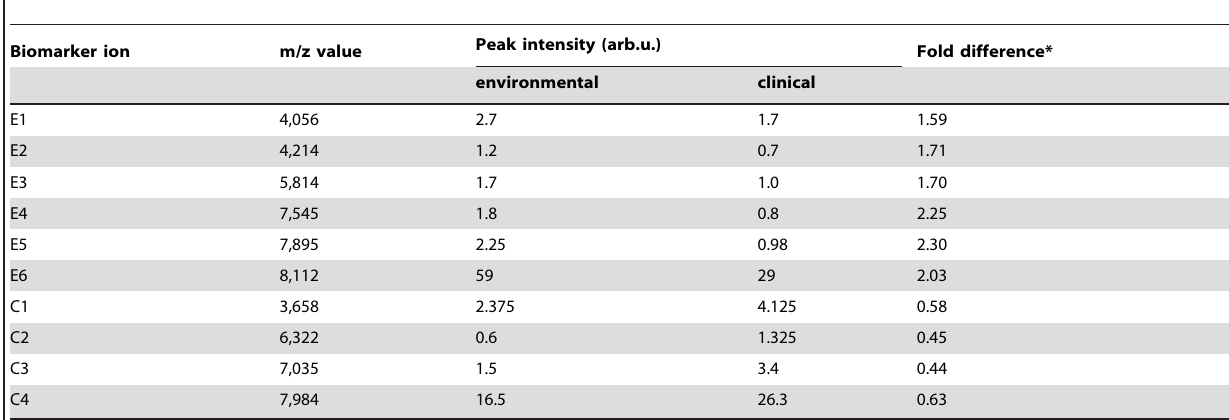
Table 2. Peak intensity values and fold differences of all source-identifying biomarker ions of B. pseudomallei .